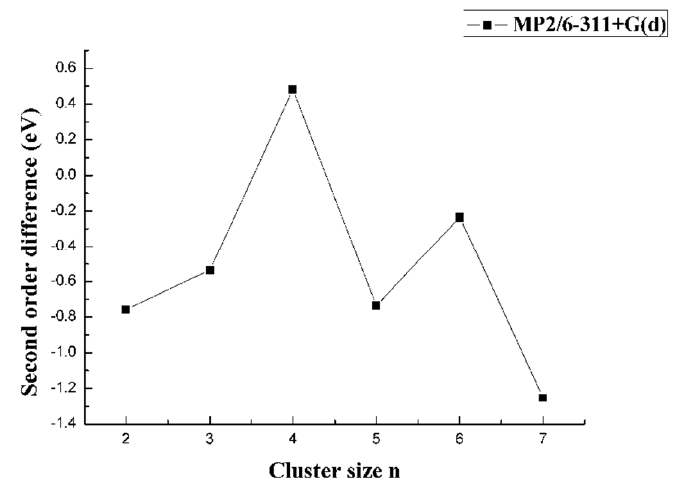
Figure 9. Size dependence of the second-order difference energy of CaB n (n = 1–8) clusters.